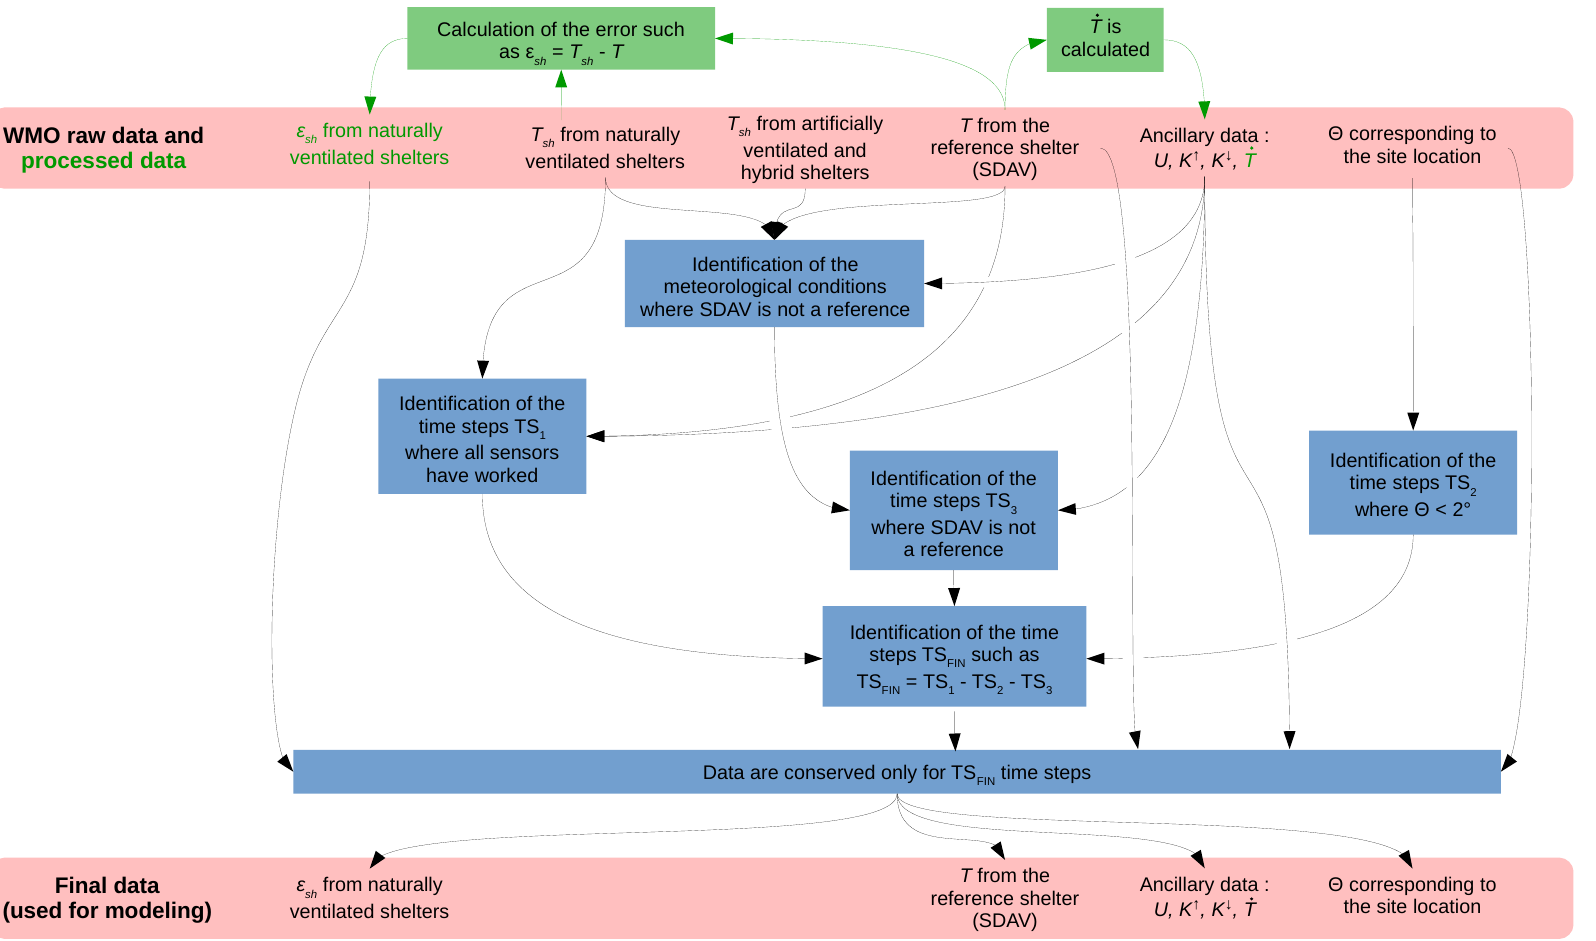
Figure 5. Processing chain used for data